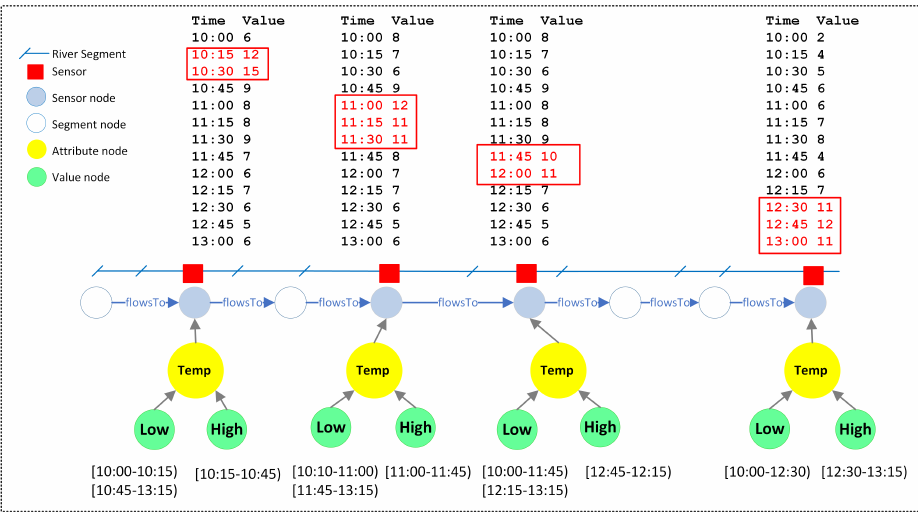
Figure 6. River network Consecutive Path with Temperature = High